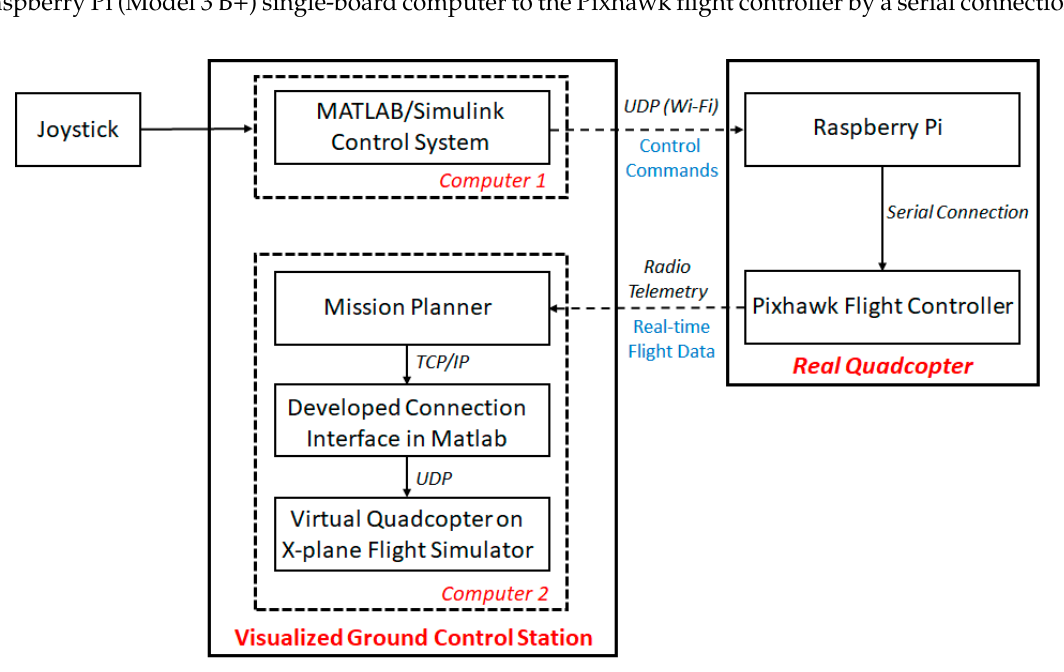
Figure 11. Control system with user datagram protocol (UDP) interface in MATLAB/Simulink.